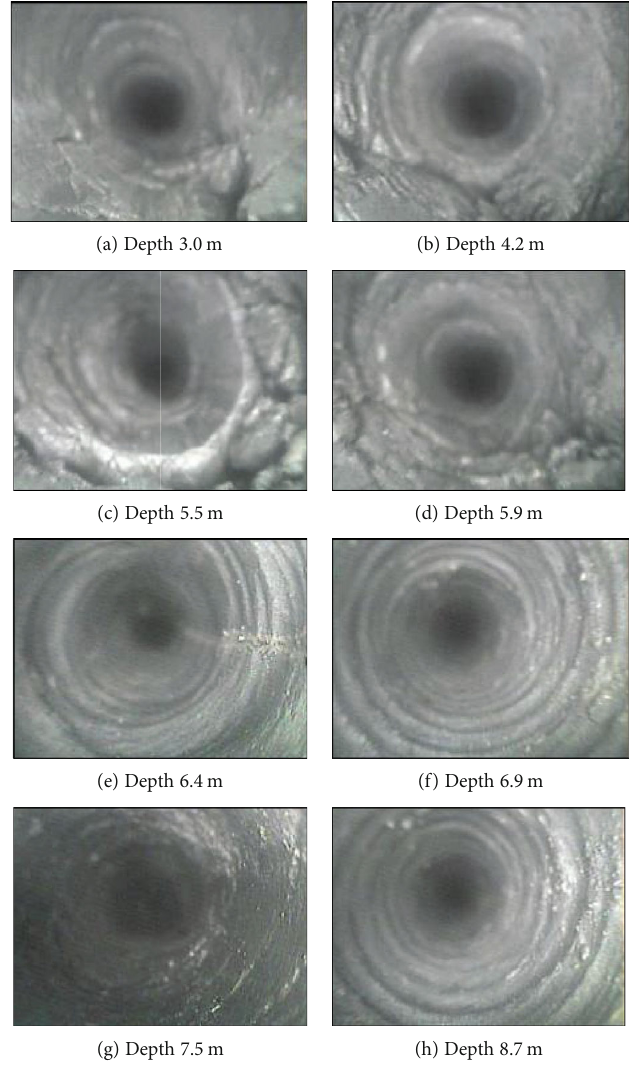
Figure 5: Borehole observation photos. Table 2: Mineral composition of surrounding rock of